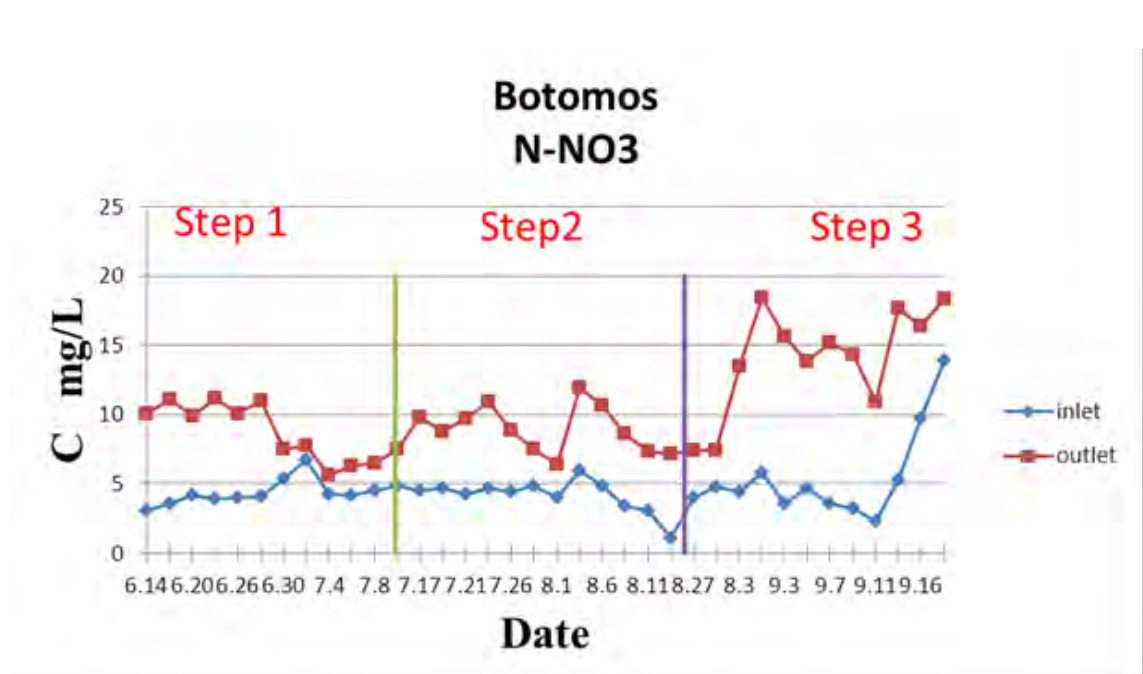
Figure 11. Efficiency removal of N-NO 3 IN Botomos tanks during three surface loads(8,6,4)m 3 /m 2 .h and tow circulation ratios (10%,20%) for each load and for one week time for each different load